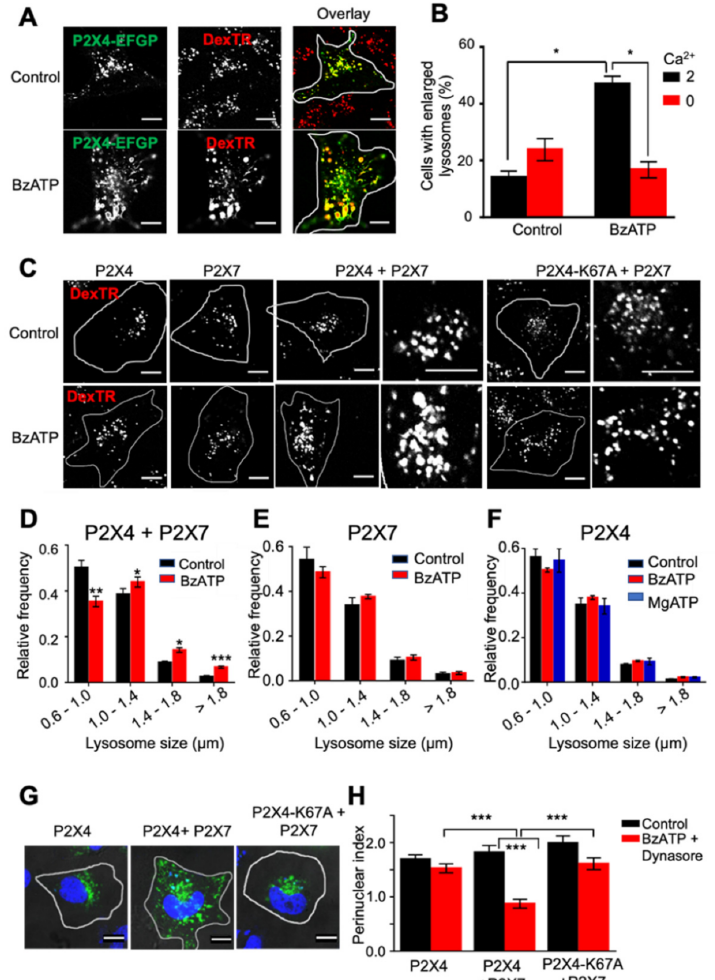
Figure 2. Activation of plasma membrane P2X7 receptors increases endolysosome size and trafficking in a P2X4 receptor-dependent manner. ( A ) In NRK cells expressing rP2X4-EGFP and rP2X7 receptors, endolysosomes were labeled with DexTR prior to treatment with 30 µ M BzATP for 0.5 h at 37 ◦ C. ( B ) A histogram of the percentage of cells with two or more enlarged DexTR positive lysosomes ( ≥ 1.8 µ m) for control and BzATP-stimulated conditions. Stimulation with BzATP was carried out in normal DMEM (2 mM Ca 2+ ) or zero Ca 2+ DMEM. ( C ) Representative images of DexTR-labeled lysosomes in cells expressing the human isoform of P2X7 alone, in combination with rP2X4-EGFP, the rP2X4K67A-EGFP mutant, or rP2X4-EGFP alone. Control cells and those treated with 100 µ M BzATP in DMEM for 0.5 h at 37 ◦ C are shown. In cells expressing hP2X7 alone, EGFP was co- expressed to identify transfected cells. The frequency distribution of lysosome size for control and BzATP-stimulated cells is shown for cells co-expressing rP2X4 and hP2X7 receptors ( D ), expressing hP2X7 alone ( E ), and expressing rP2X4 alone ( F ). For cells expressing rP2X4 alone, a comparison was also made with cells treated with MgATP (100 µ M) for 0.5 h at 37 ◦ C. For statistical analysis, lysosome trafficking, cells expressing either rP2X4 alone or co-expressing either wild-type rP2X4 or rP2X4-K67A with hP2X7 were treated with BzATP (100 µ M, 0.5 h) and dynasore (80 µ M, 0.5 h), fixed, and immunostained with an anti-P2X4 antibody and a FITC-labeled anti-rabbit secondary antibody.